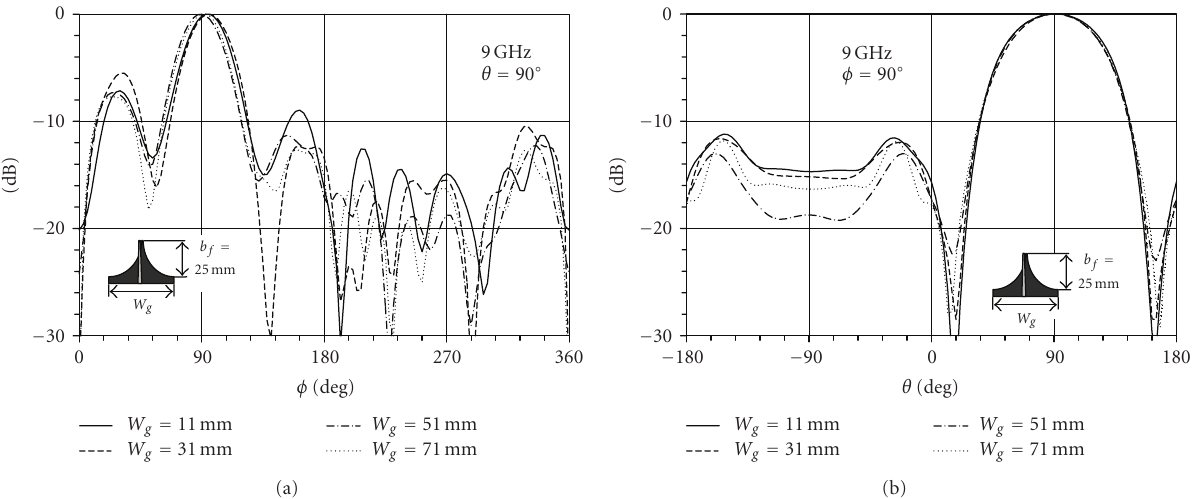
Figure 15: Radiation patterns of DETASAs for changing width of tapered ground, W g , in (a) E-plane, (b)